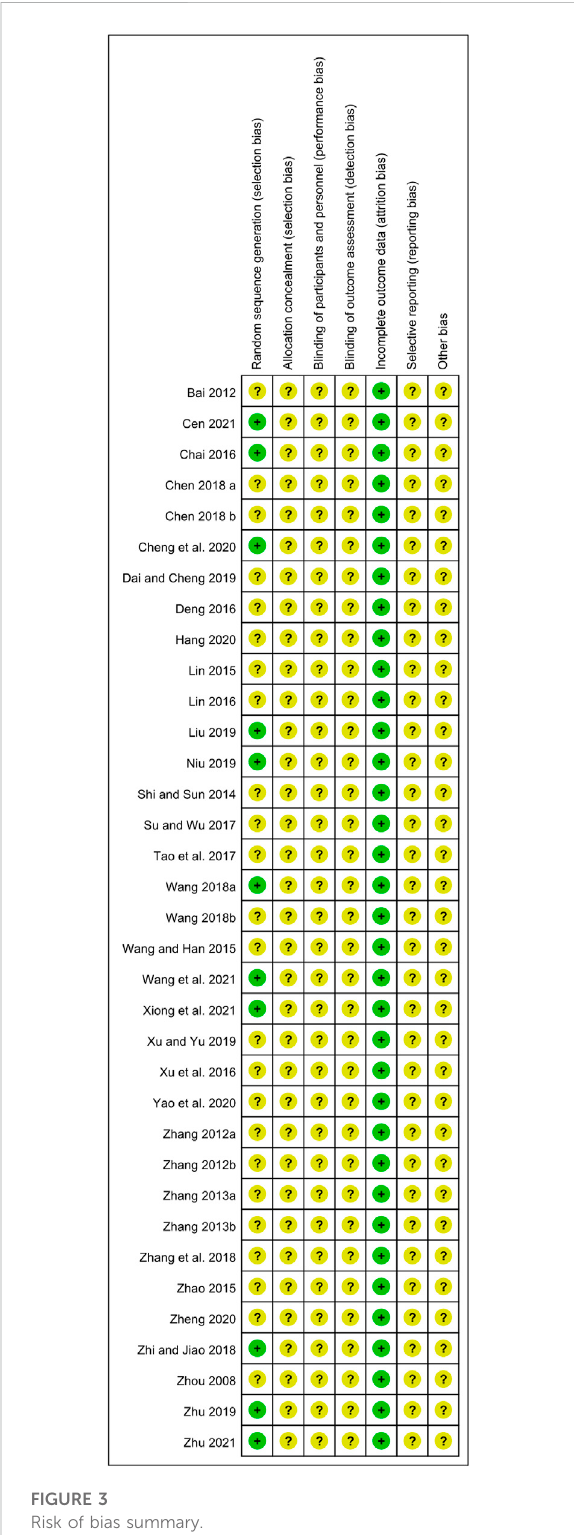
FIGURE 3 Risk of bias